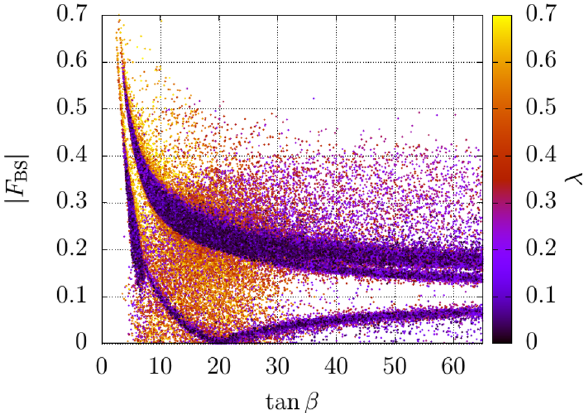
Figure 10 . Variation of the blind spot construct of eq. (3.5) as a function of tan β . Associated ‘ λ ’ values are presented via the palette. See text for